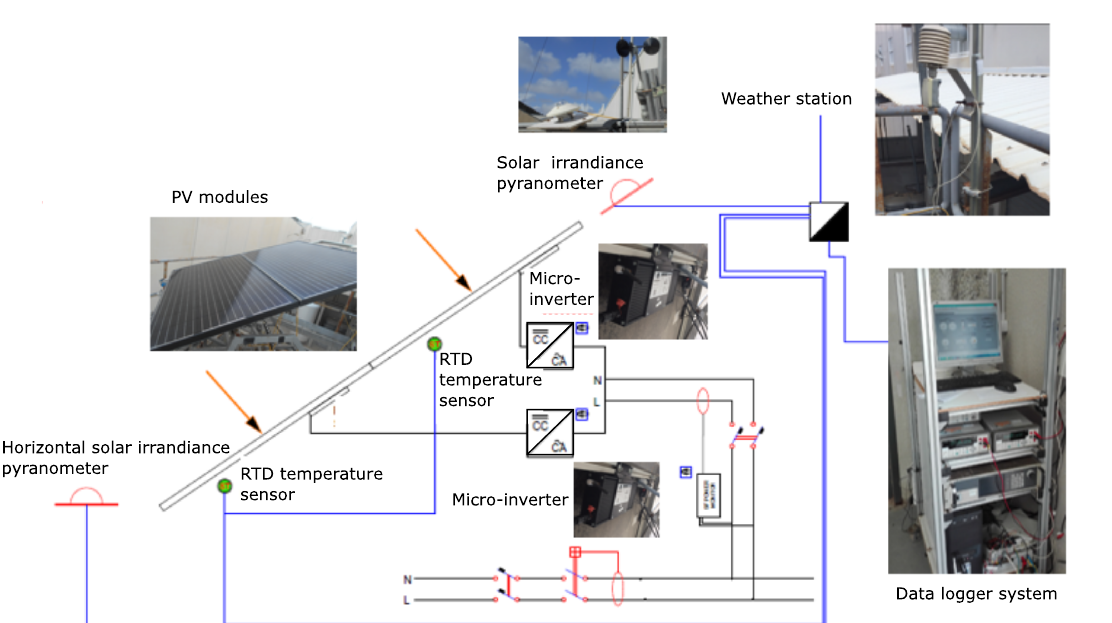
Figure 8. Photovoltaic (PV) module installation: monitoring and